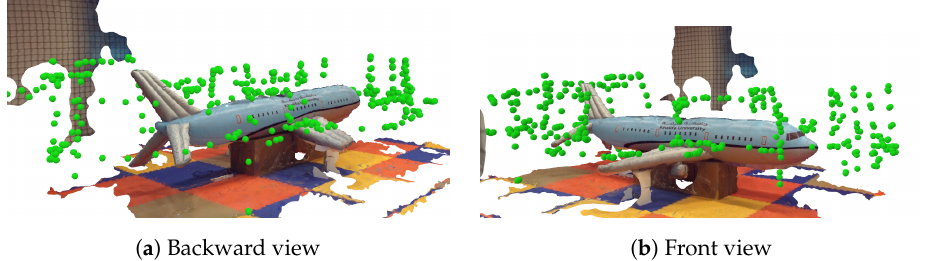
Figure 18. The 3D reconstructed airplane model utilizing the collected images during the NBV mission. The locations of the gathered images are presented in green